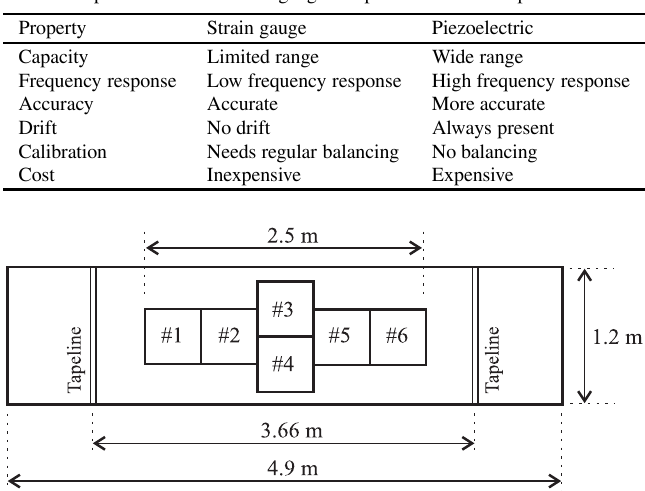
Table 1 Comparison between strain gauge and piezoelectric force